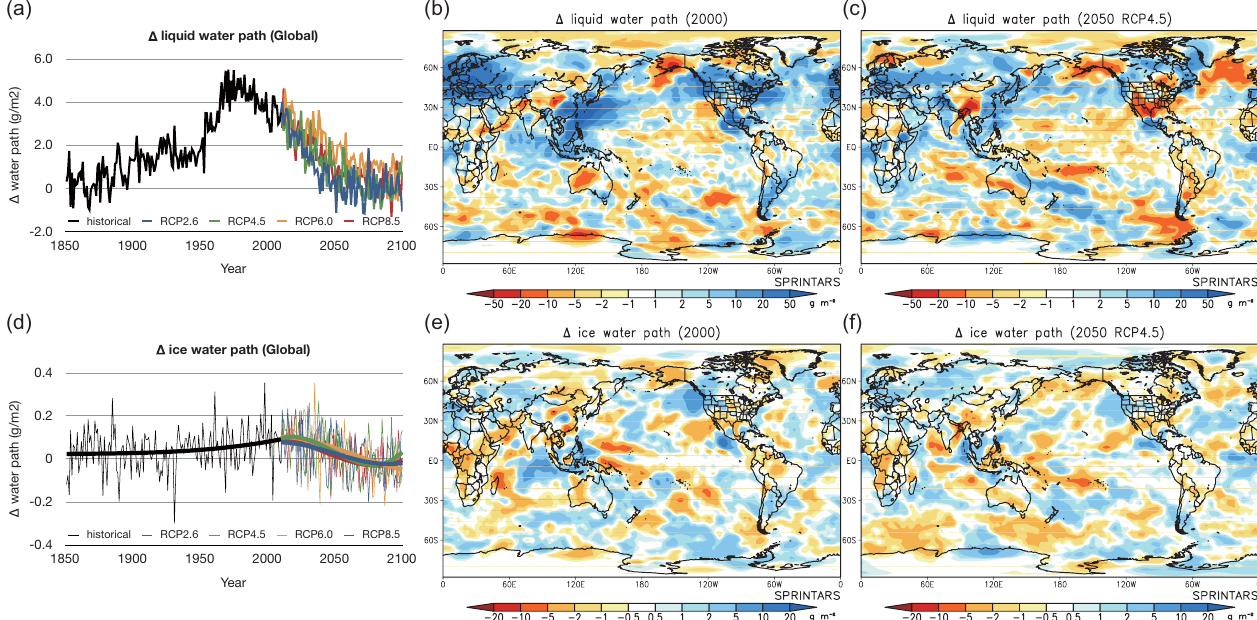
Fig. 13. Time series of changes in annual and global mean water paths of (a) liquid and (d) ice, and global distributions of changes in water paths of (b) liquid and (e) ice in 2000 (averaged over the period 1998–2002) and (c) liquid and (f) ice in 2050 (averaged over the period 2048–2052) for the RCP4.5 experiment relative to the preindustrial experiment simulated by SPRINTARS. In (a) and (d) , the historical period is shown in black, and the four RCPs are shown in colours. In (d) , thick lines are regression